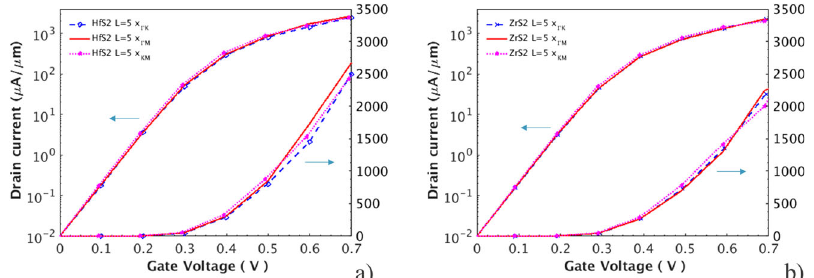
Fig. 9 I D ( V G ) characteristics of group-IV TMD along principal crystallographic axes. I D ( V G ) characteristics of group-IV TMD nMOSFETs for three different channel orientations along principal crystallographic axes ( Γ K, Γ M, and KM), a for HfS 2 and b for ZrS 2 . V D = 0.6 V. L = 5 nm. I OFF = 10 nA/ μ m. e-ph scattering is